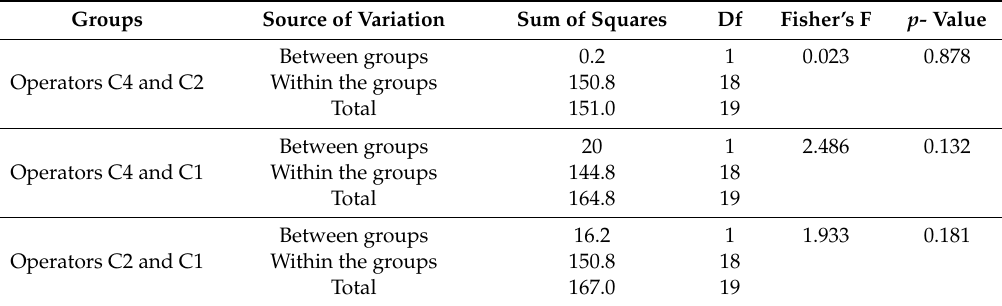
Table 4. Analysis of variance of the unsolved FA.